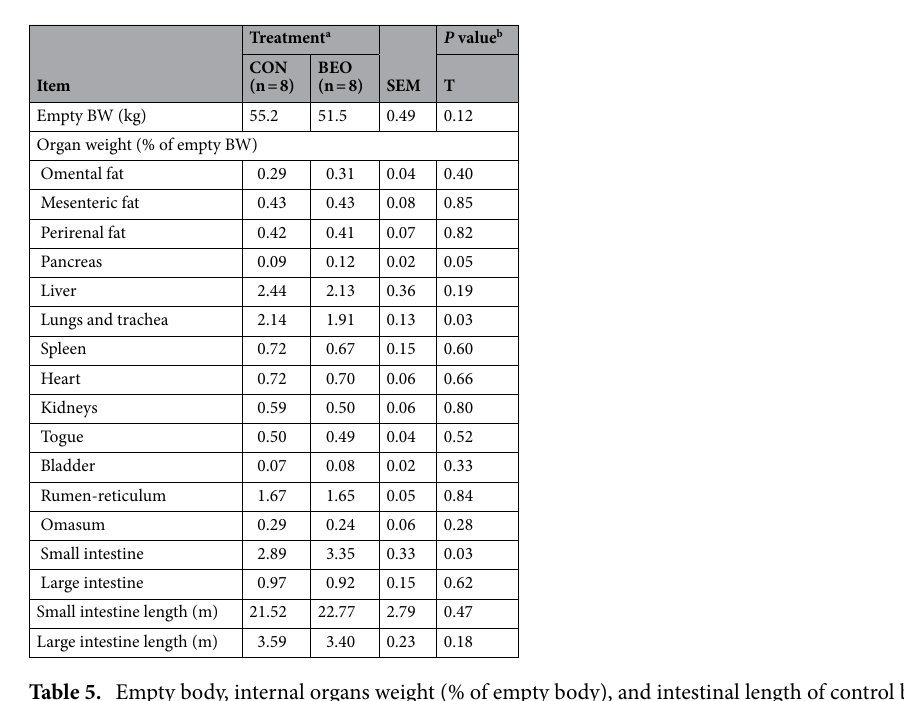
Table 5. Empty body, internal organs weight (% of empty body), and intestinal length of control bull calves (CON) and bull calves supplemented with a blend of essential oils (BEO) in milk replacer from 4 to 60 days of age. a CON = control; BEO = 1 g/calf/day blend of essential oil. b T = treatment